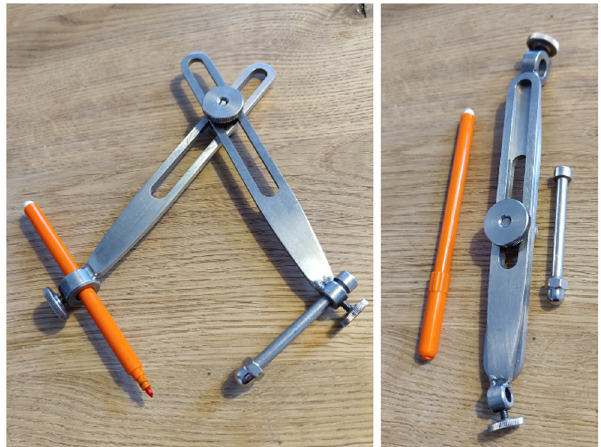
Fig 7. Craniotomy caliper. The demands to a caliper to facilitate the marking part of this method have been addressed in this model designed by the first author: The contact point of the center leg is smooth and can be inserted to the porus and placed on nasion. The length of legs of the caliper can be adjusted and together with the fix angle chosen for the mounting rings, this length adjustment allows to keep the angle of the center leg and the marker nearly vertical to the skin at all different convexity locations, which reduces the error. The mounting rings allow to insert different diameters of markers. The tool can be folded up and fits in a